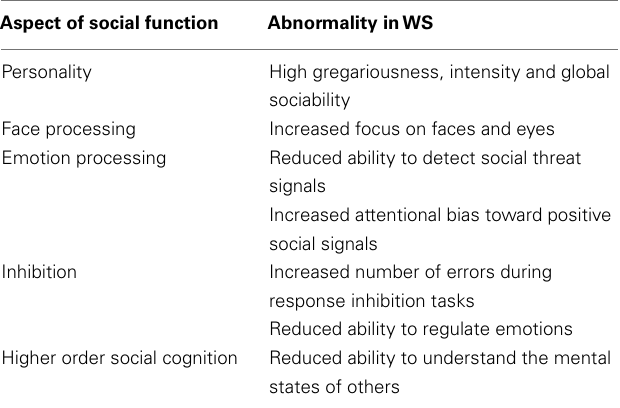
Table 1 | Summary of social phenotype